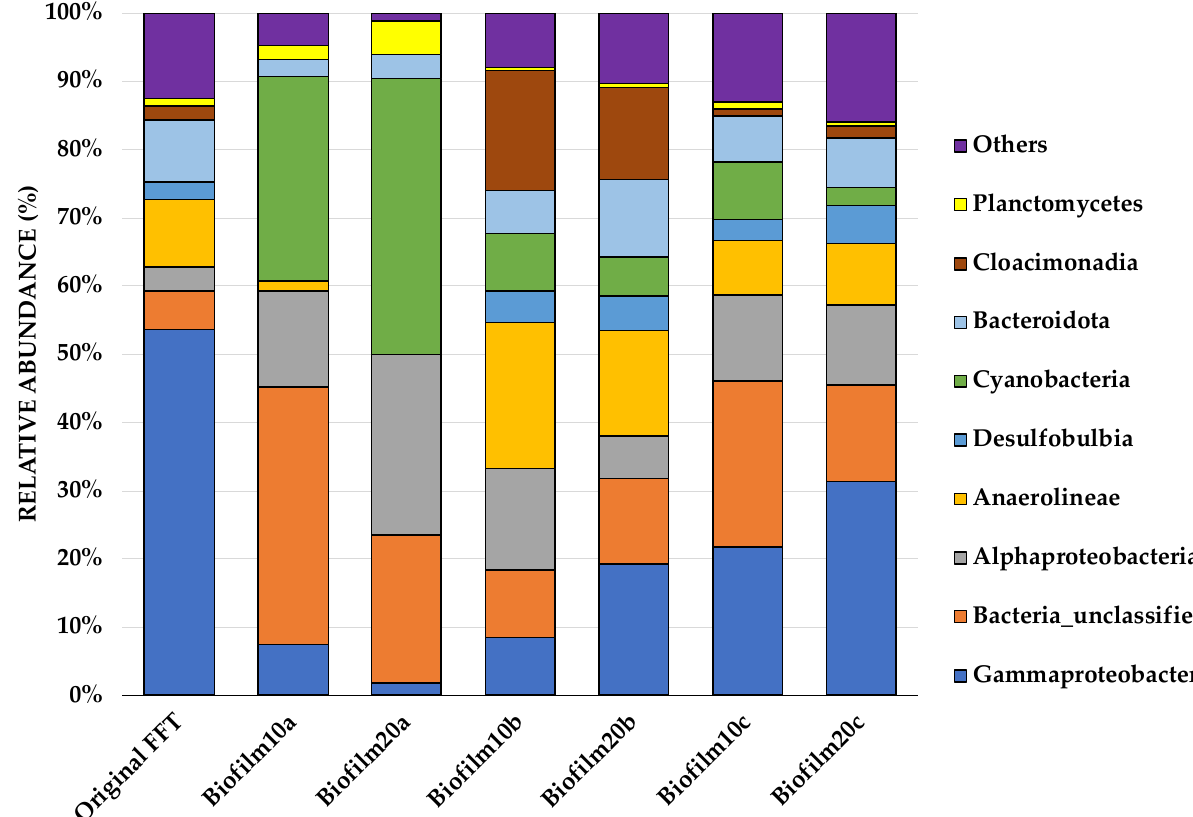
Figure 2. Stacking bars illustrating the relative abundances of microorganisms at the class level, represented by the percentage of the 16S rRNA read counts within each group. A relative abundance of less than 1% is assigned to ‘Others’. Original FFT refers to the FFT sampled before biofilms were inoculated and grown in jars. Biofilm10 corresponds to 10-week-old biofilms; Biofilm20 corresponds to 20-week-old biofilms. Biofilm10a and Biofilm20a refer to biofilm samples taken from the top layer of the biofilms. Biofilm10b and Biofilm20b refer to distinct pink microbial communities that were seen developing below the FFT–water interface (see Supplementary Figure S1). Biofilm10c and Biofilm20c refer to distinct black microbial communities that were seen developing below the FFT–water interface (see Supplementary Figure S1).